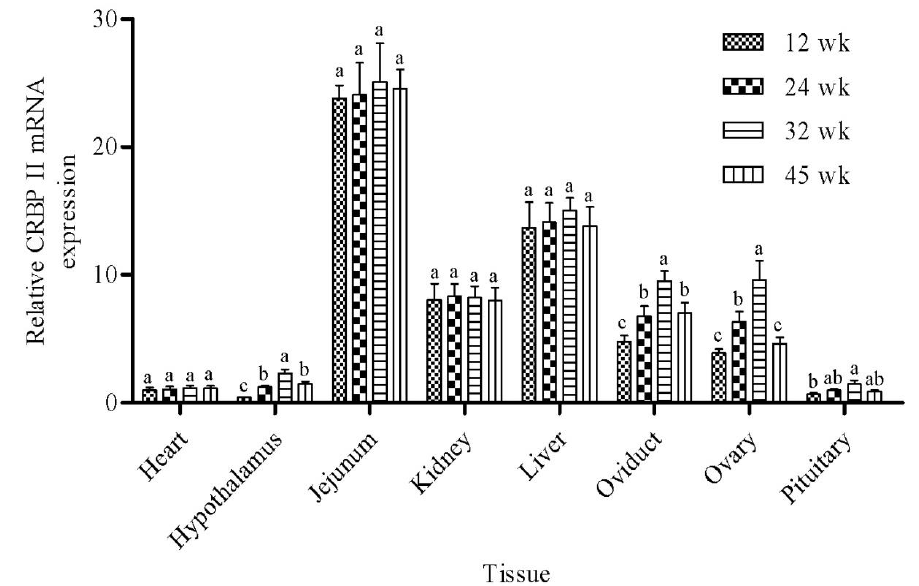
Figure 2. The CRBP II mRNA abundance in different tissues at 12, 24, 32, and 45 weeks (wk) of age in Erlang Mountainous chickens. Bars represent the mean  SEM. There was an interaction of age  tissue for CRBPII mRNA (p = 0.021). Different letters within the same tissue above the column indicate significant differences among time points